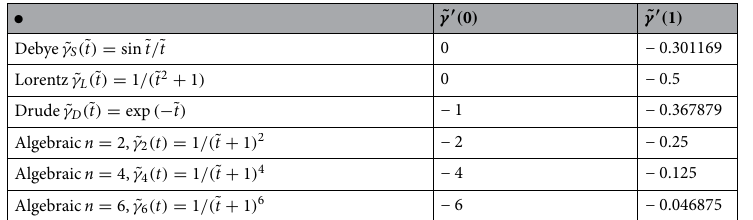
Table 1. Numerical values of the derivatives t t 0 and 1 , i.e. for the memory time t for ˜ ˜ = = particle